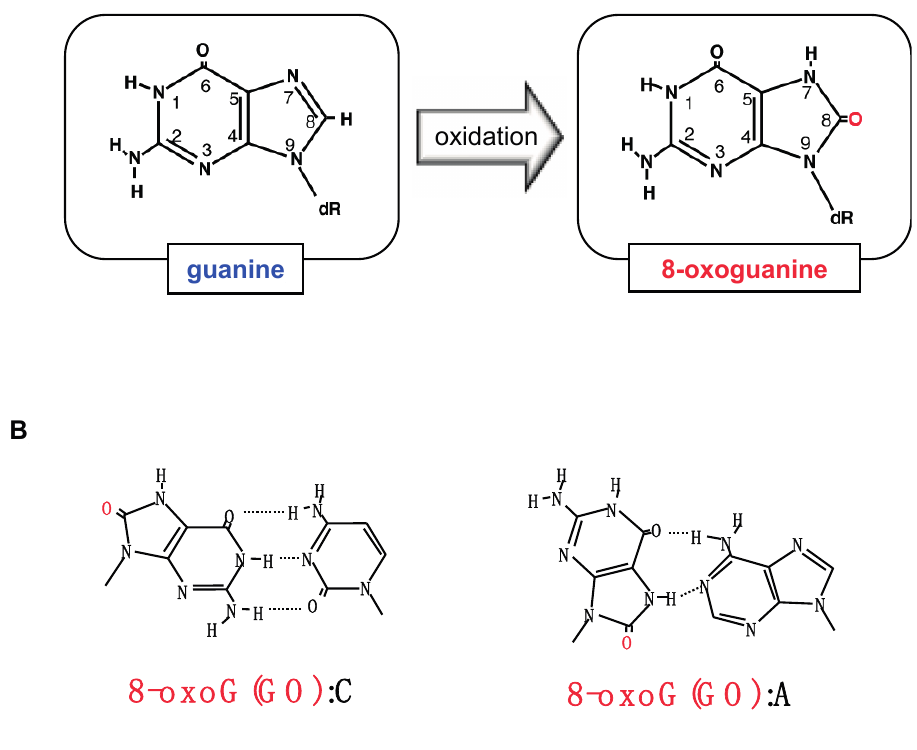
Figure 1. Formation of 8-oxoguanine and its altered base pairing property. ( A ) Oxidation of guanine base by reactive oxygen species (ROS) generates 8-oxoguanine; ( B ) 8-Oxoguanine (GO) forms a base pair with adenine as well as with cytosine in DNA. Modified from